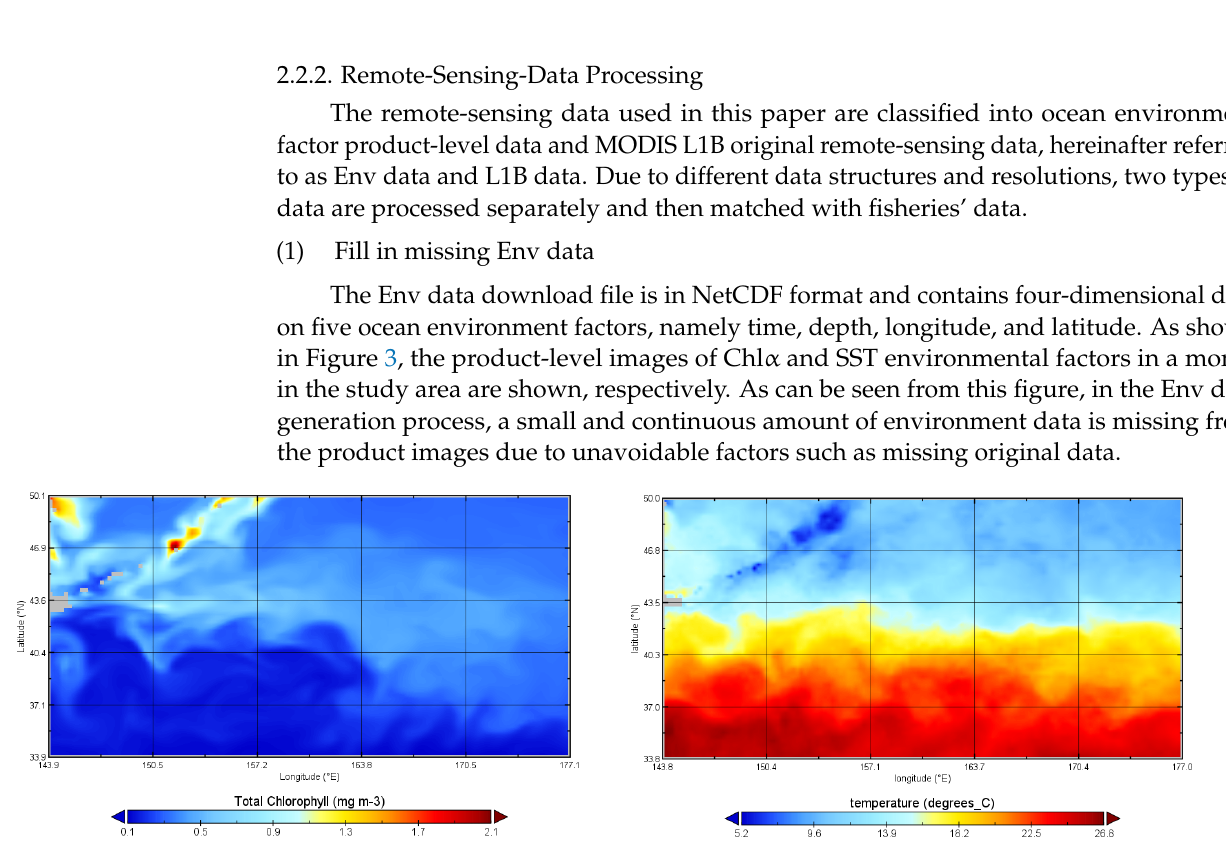
Figure 2. Example of data expansion in fisheries’ datasets.